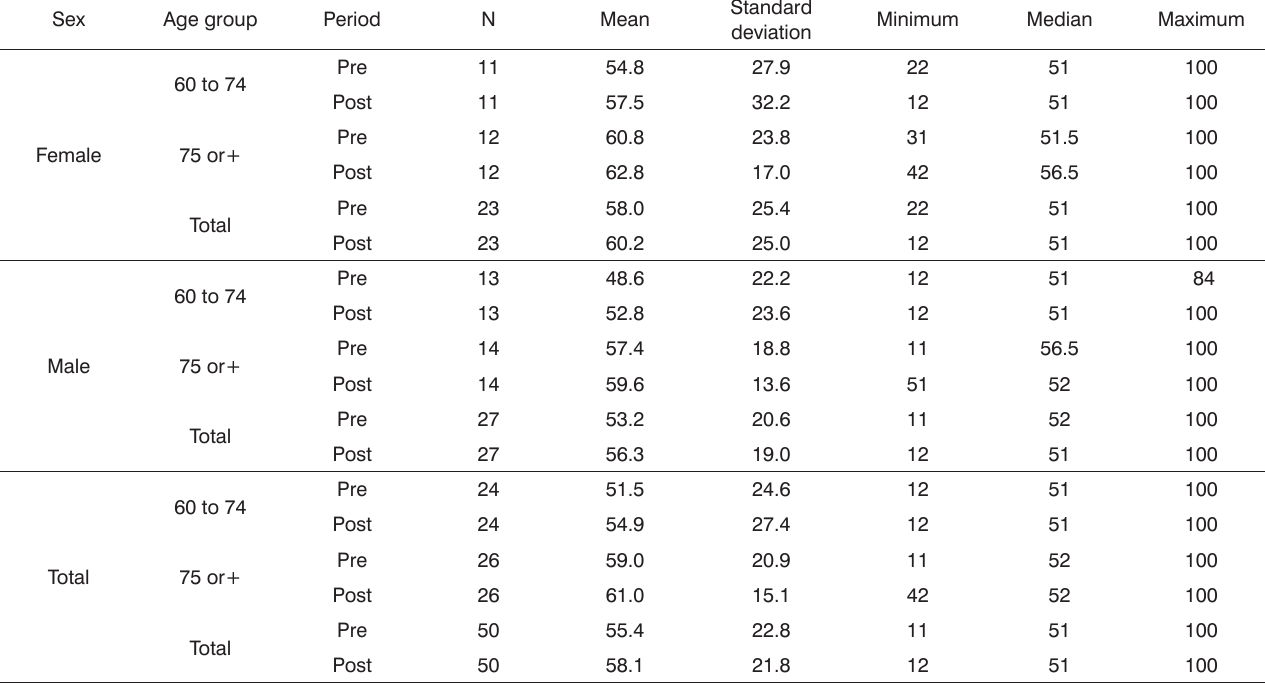
Table 6. Analysis of variance and descriptive statistics of the pain aspect according to sex and age